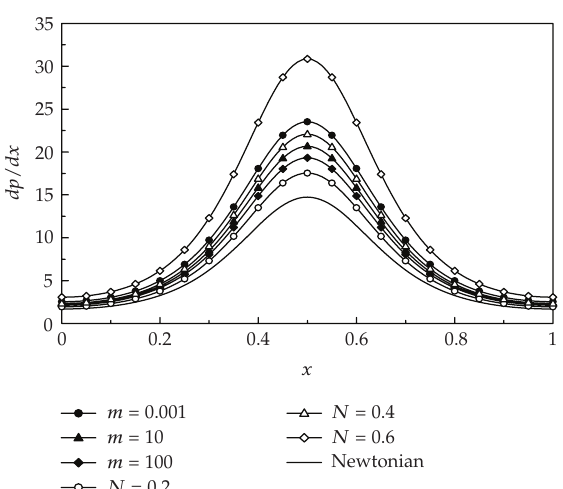
Figure 1: The axial pressure gradient versus the wavelength for α (cid:8) 0 . 3 , θ (cid:8) − 1 . 2 , H (cid:8) 2 and di ff erent values of m and N .